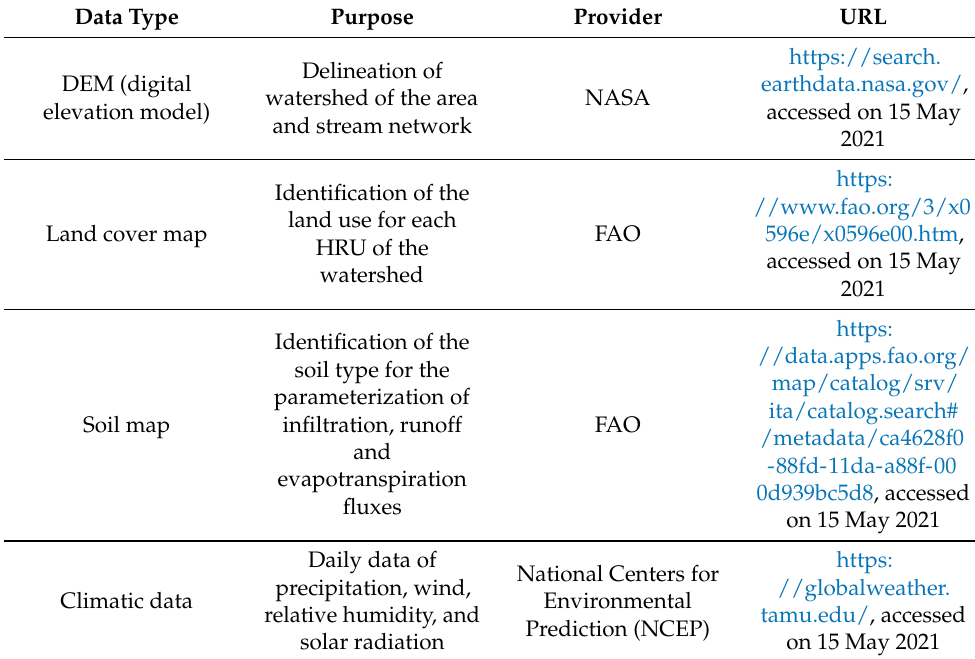
Table 1. Data collection: DEM, land cover map, soil map,